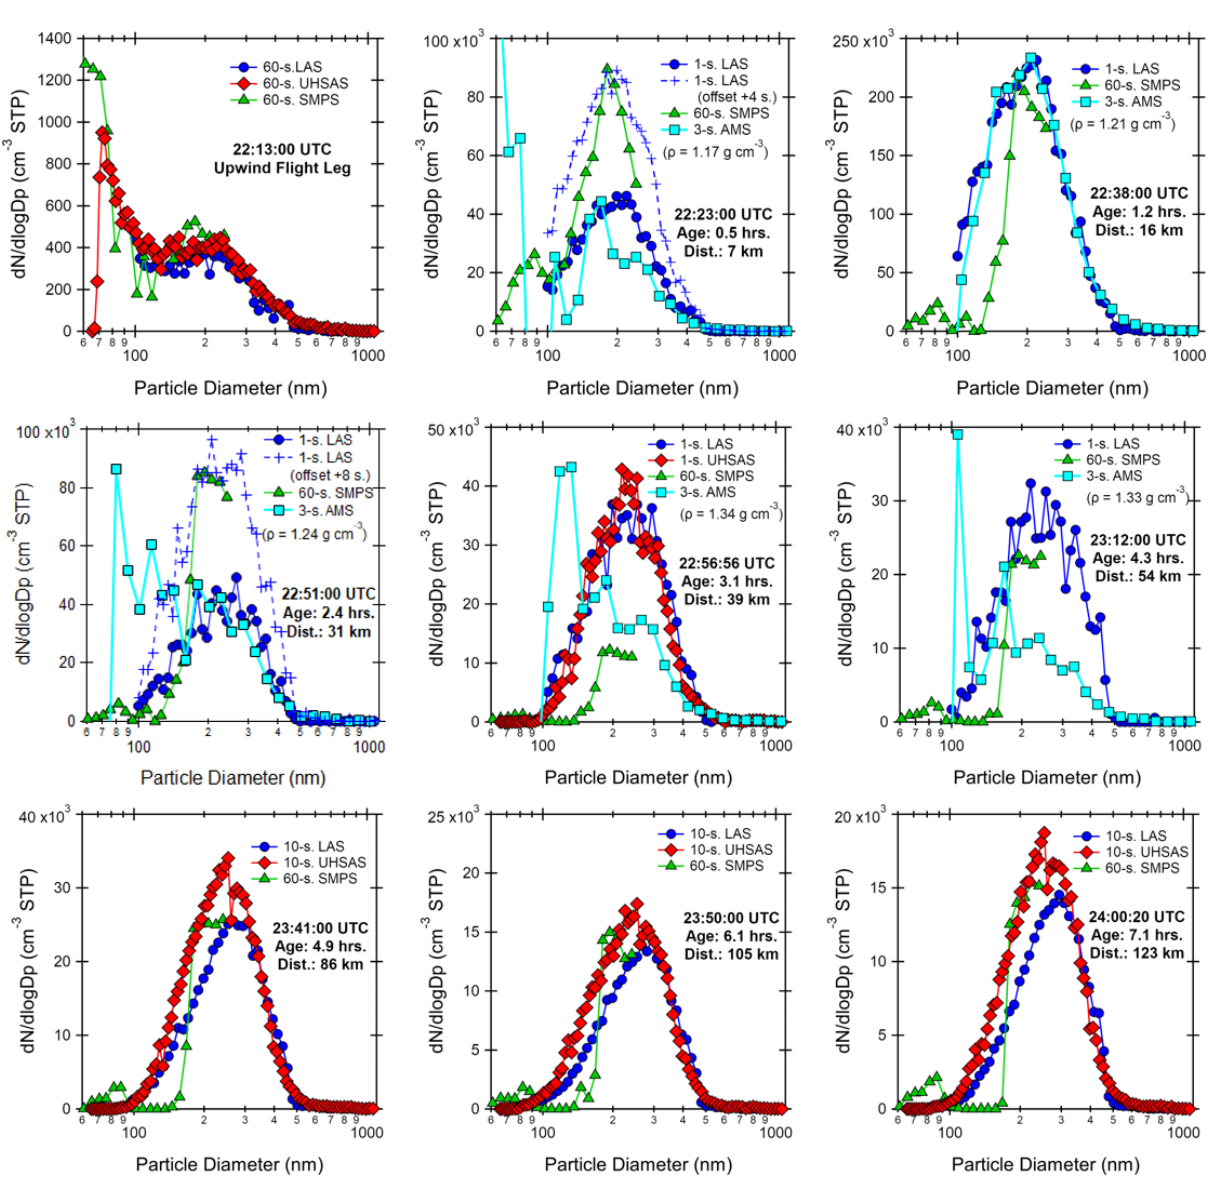
Figure 10. Comparison of the size distributions measured by the LAS, UHSAS, and SMPS at multiple downwind distances from the Williams Flats Fire in the state of Washington, USA, during the 3 August 2019 FIREX-AQ flight. In some of the early plumes, the 60s SMPS distribution was heavily skewed toward a short portion of the plume, in which case an additional LAS trace corresponding to this peak is included for the comparison. Smoke ages and downwind distances from the fire are noted for each set of size distributions and correspond to those given in Figs. 8 and 9. As explained in the text, the mass to number conversion for the AMS data is very sensitive to small shifts at small sizes; hence the AMS number data below ∼ 120nm are fairly uncertain. Reported sizes are for dry particles (RH <